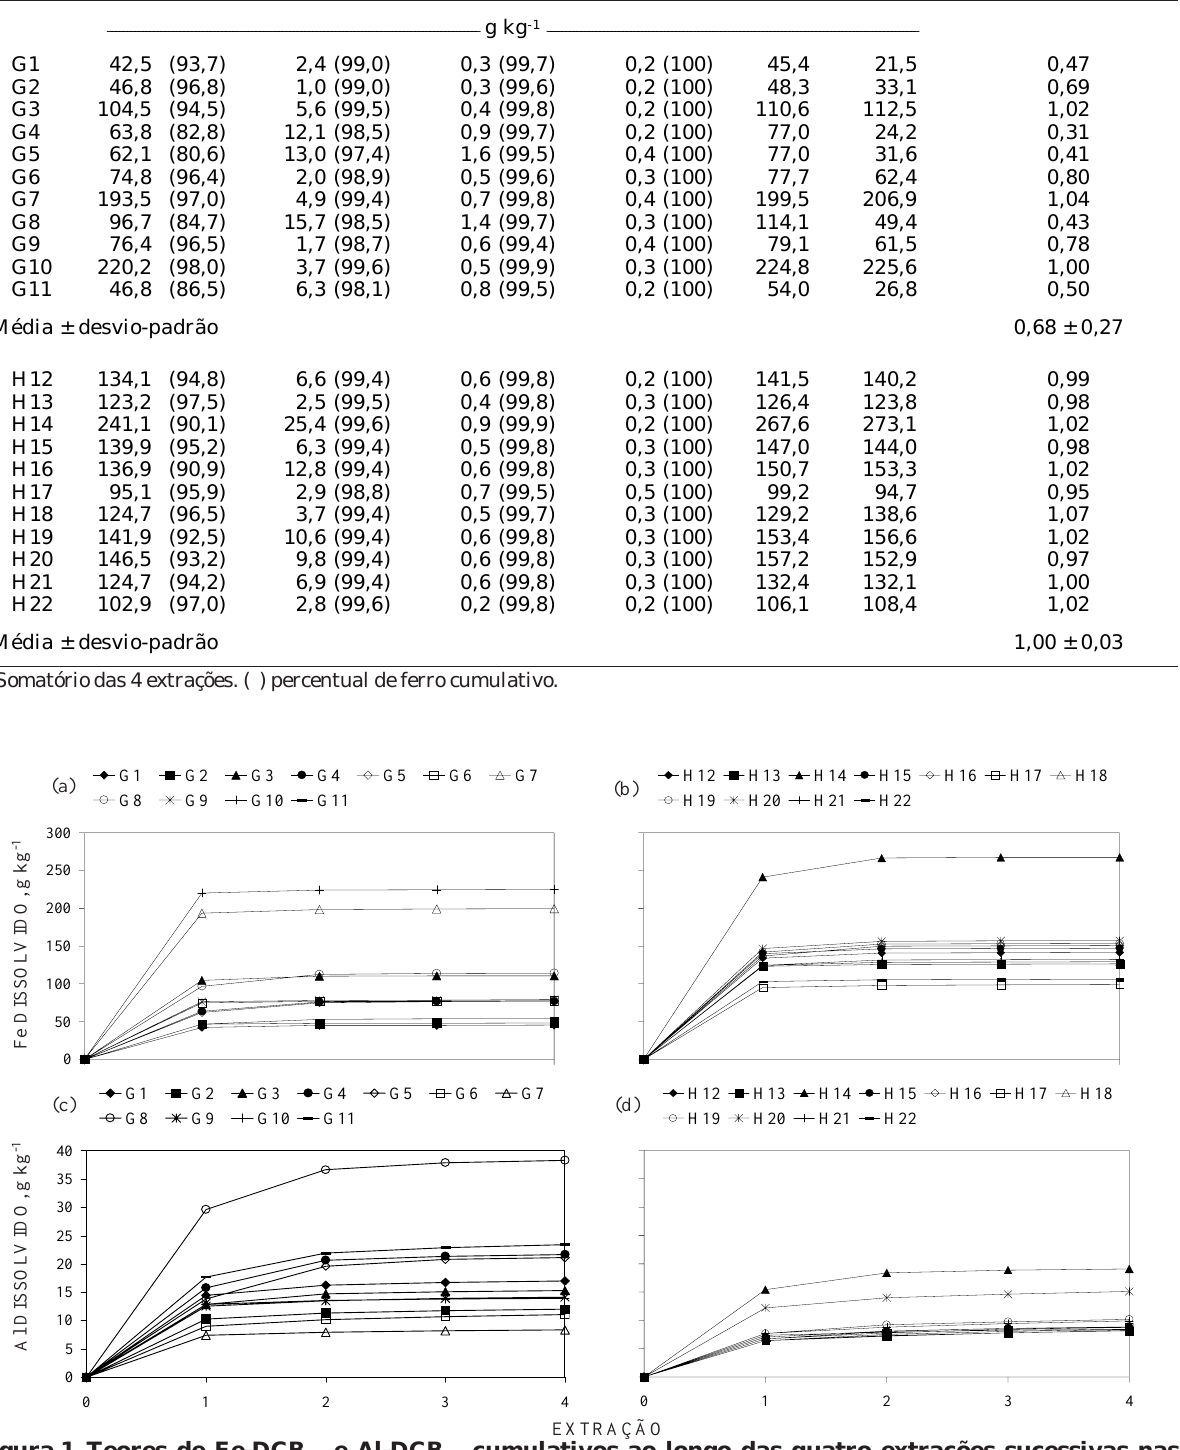
Figura 1. Teores de Fe-DCB e Al-DCB cumulativos ao longo das quatro extrações sucessivas nas 80 80 amostras goethíticas (a, c) e hematíticas (b,